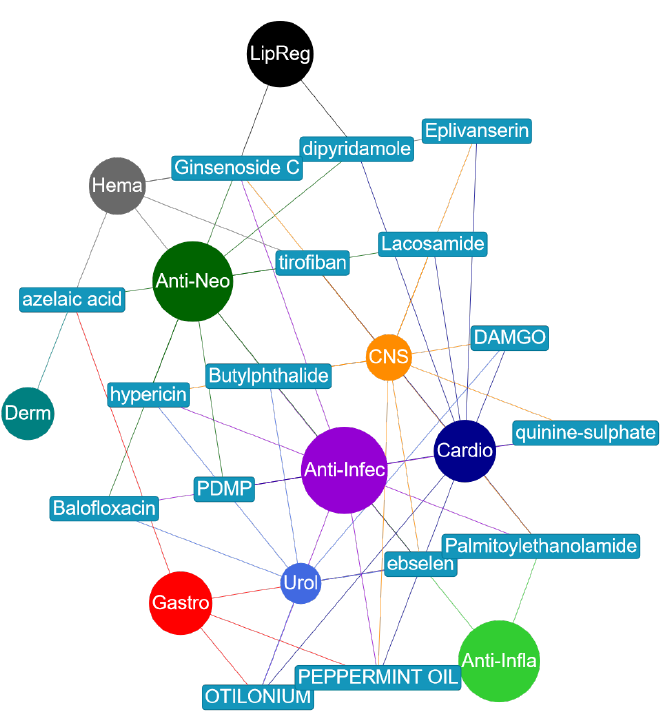
Figure 8. A network of misclassified drugs. The MeSH classes are presented as circular nodes whereas drugs are shown in rectangular boxes. Each drug is connected to two or more MeSH classes to which it has been predicted to belong. An edge linking a drug node and a MeSH class node inherits the color of the MeSH class node. Thus, drug nodes have different colors for edges attached to them whilst MeSH class nodes have the same color to all their edges. This network was drawn using Pyvis